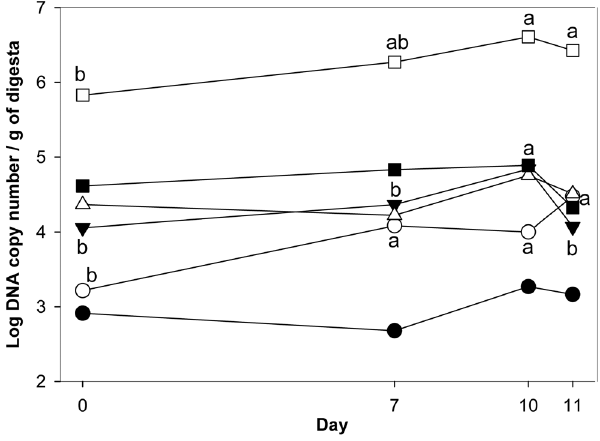
Figure 3. Gene copy numbers for major bacterial groups per N gram of cecal digesta at day 0, 7, 10, and 11 in Exp 1. Symbols ), Citrobacter freundii ( # ), Klebsiella oxytoca indicate Proteus mirabilis ( ( . ), Escherichia coli ( D ), Staphylococcus spp. ( & ), and Enterococcus spp. ( % ). Data are shown as mean 6 SEM. Values obtained with the same primers that do not share a common letter differ significantly; i.e. vary over time.